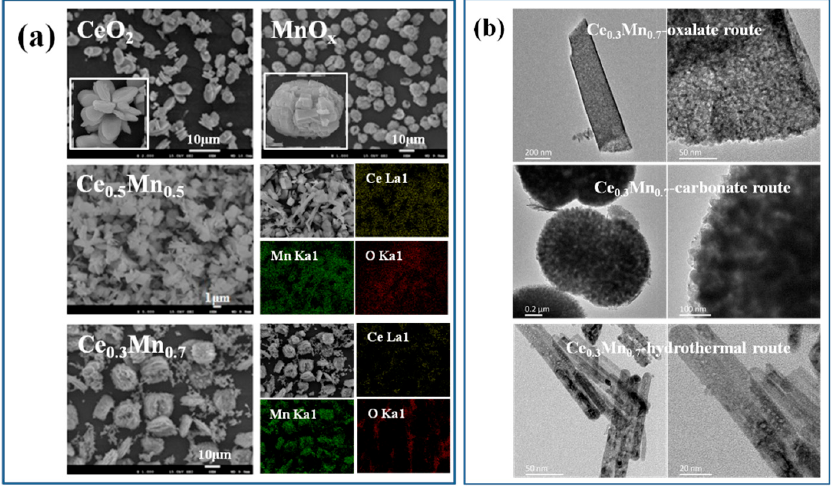
Figure 3. SEM images and EDX mapping of CeO 2 , MnO x , Ce 0.5 Mn 0.5 and Ce 0.3 Mn 0.7 ( a ); TEM images of Ce 0.3 Mn 0.7 synthesized through different routes ( b